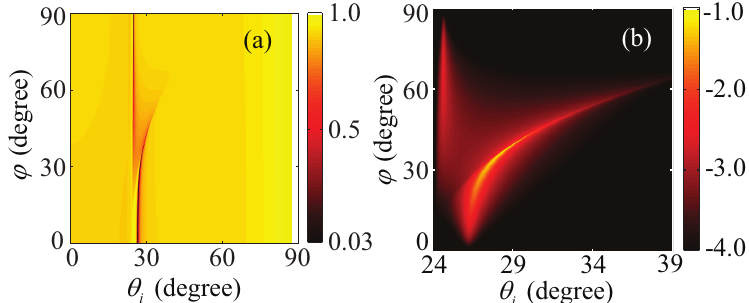
Figure 5. Reflectance spectra of the Kretschmann configuration with a strongly electrically anisotropic uniaxial dielectric cladding. ( a ) The total reflectivity R of the incident angle ( θ ) and the azimuth angle ϕ between the optical axis and the + X axis; i ( b ) Detail of the part R in ( a ), and the color bar on a log 10 scale, i.e. , lg( R TE